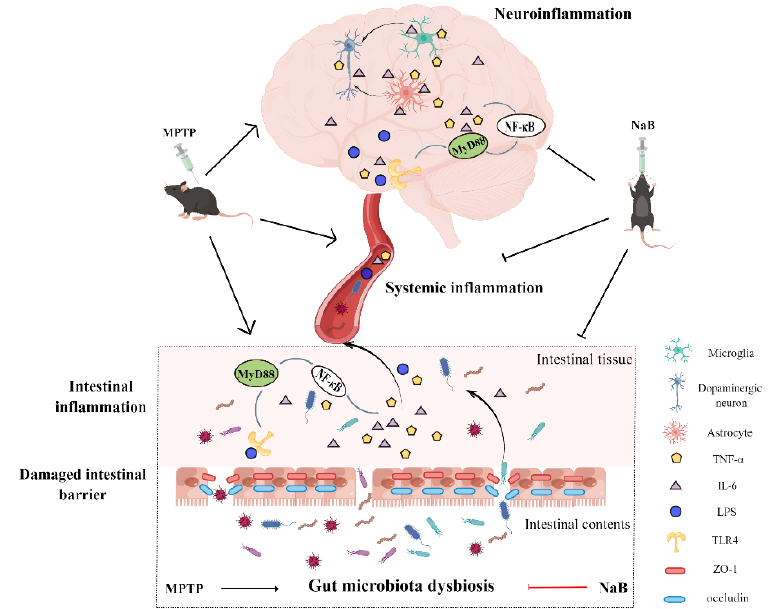
Figure 8. Overview of the protective mechanisms of Sodium butyrate (NaB) treatment in mice with 1-methyl-4-phenyl-1,2,3,6-tetrahydropyridine (MPTP)-induced Parkinson’s disease (PD). NaB treat-